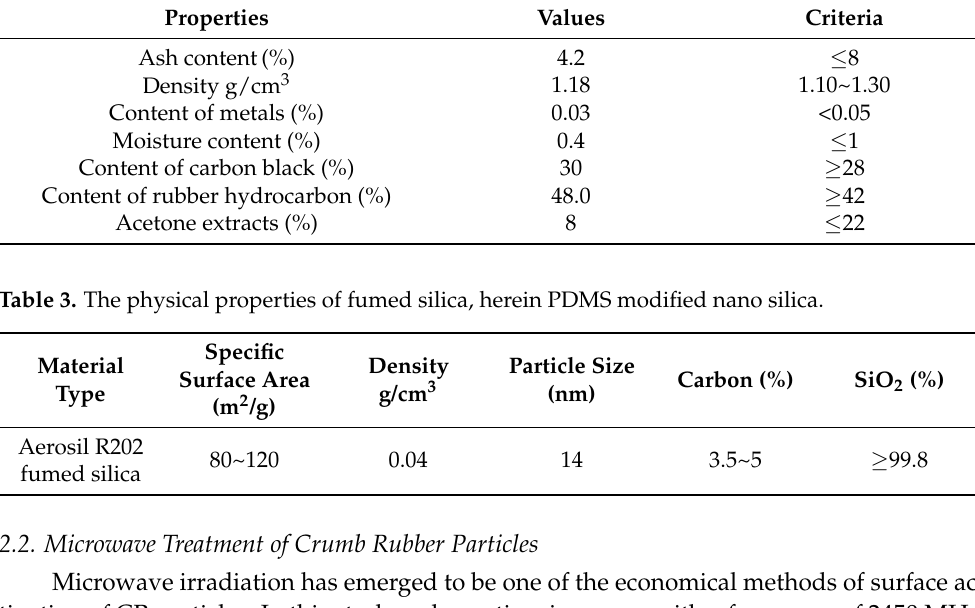
Table 2. Fundamental properties of un-activated crumb rubber particles.